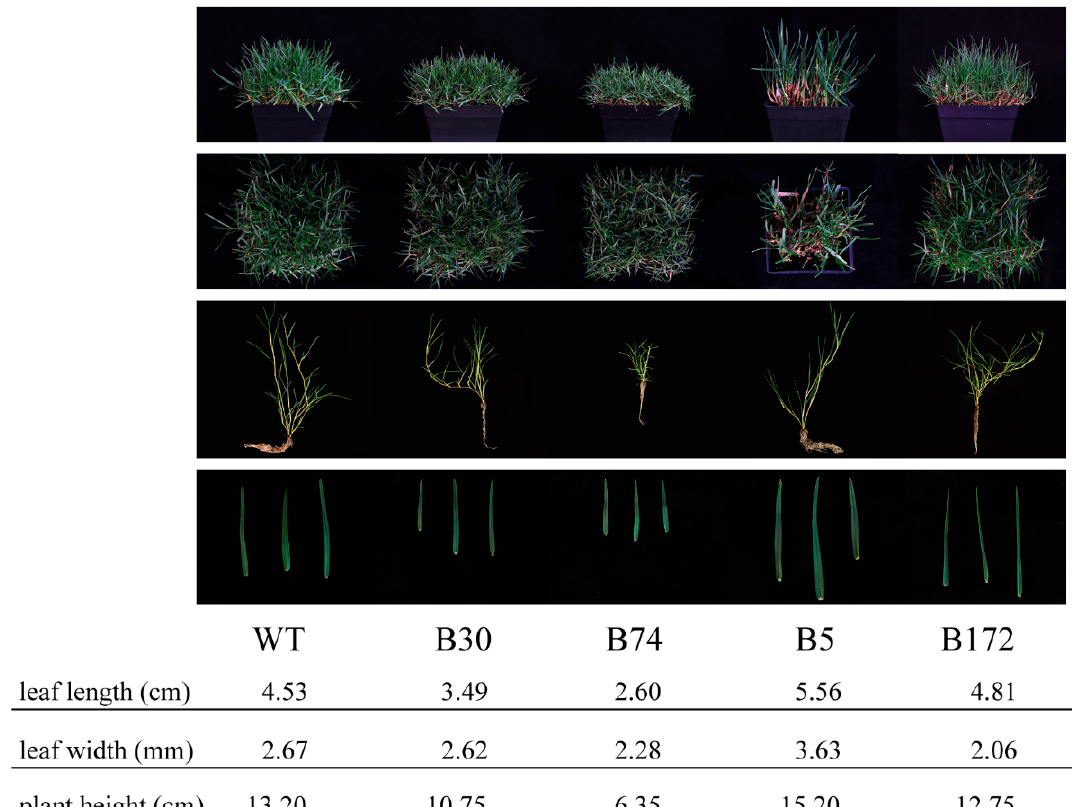
Figure 4. WT and 4 representative mutant lines.